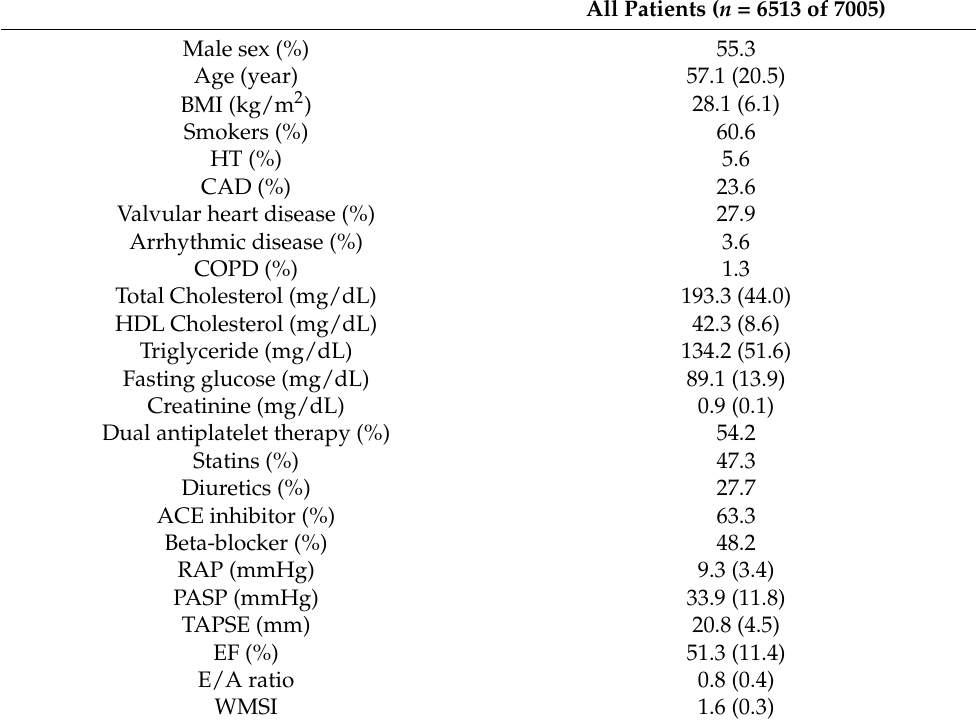
Table 1. Clinical and demographic